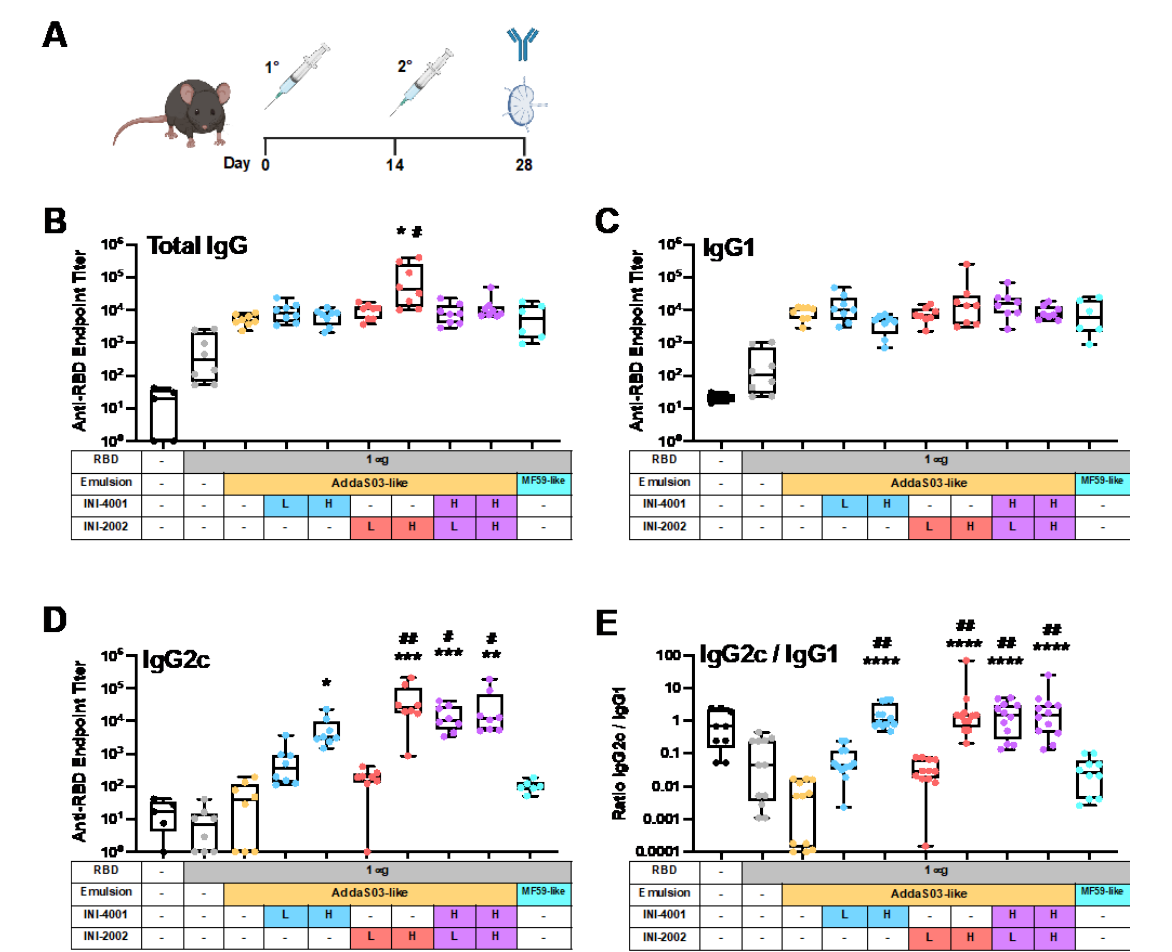
Figure 5. Addition of TLR4 and/or TLR7/8 agonists to AddaS03-like emulsions increases RBD-specific IgG2c antibody titers without reducing total IgG or IgG1 titers. ( A ) C57BL/6 mice were immunized twice with recombinant SARS-CoV-2 RBD admixed with emulsions containing INI-4001 (TLR7/8 agonist) or INI-2002 (TLR4 agonist), singly or dually encapsulated. Agonists were administered at a low dose (L, 0.876 nmol) or high dose (H, 8.76 nmol). Fourteen days after the booster immunization, anti-RBD serum antibody titers were measured for ( B ) total IgG, ( C ) IgG1, ( D ) IgG2c, and ( E ) the ratio of IgG2c/IgG1. Results are presented as box-and whisker plots representing